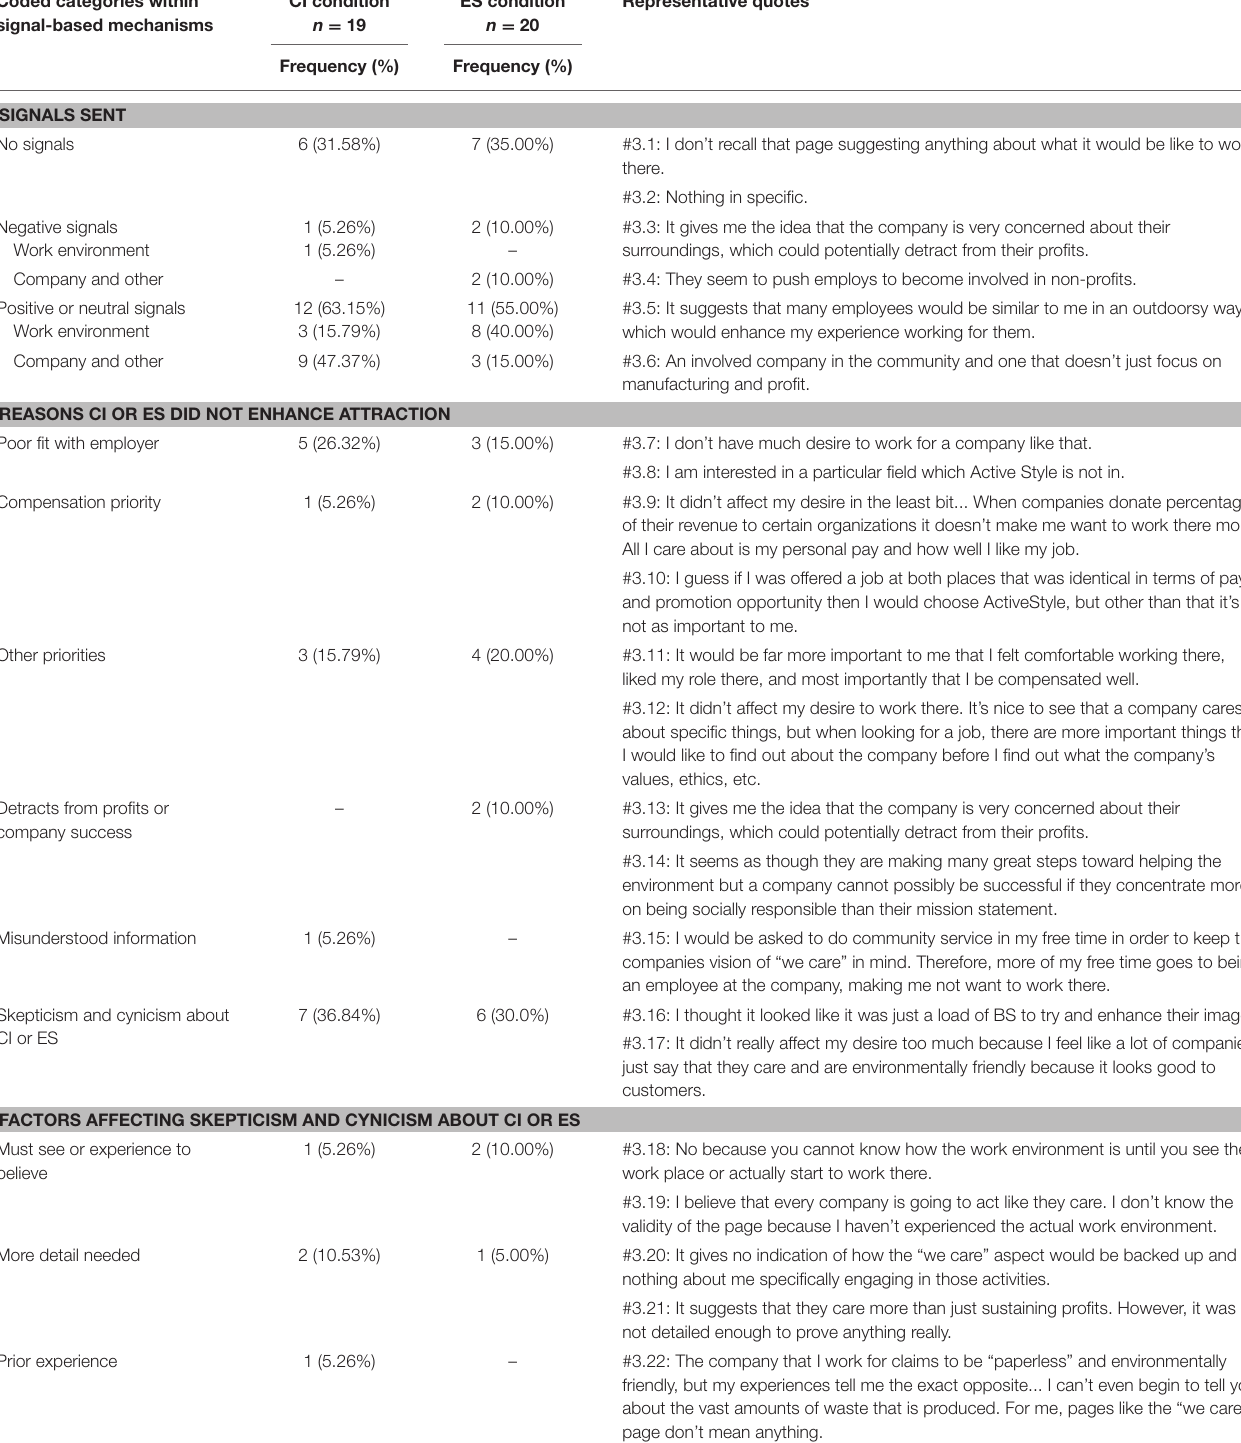
TABLE 3 | Frequencies and Percentages of Responses about an Employer’s Community Involvement (CI) or Environmentally Sustainable (ES) Practices among Participants who Reported No Effect ( n = 36) or a Negative Effect ( n = 3) on their Attraction. Coded categories within signal-based